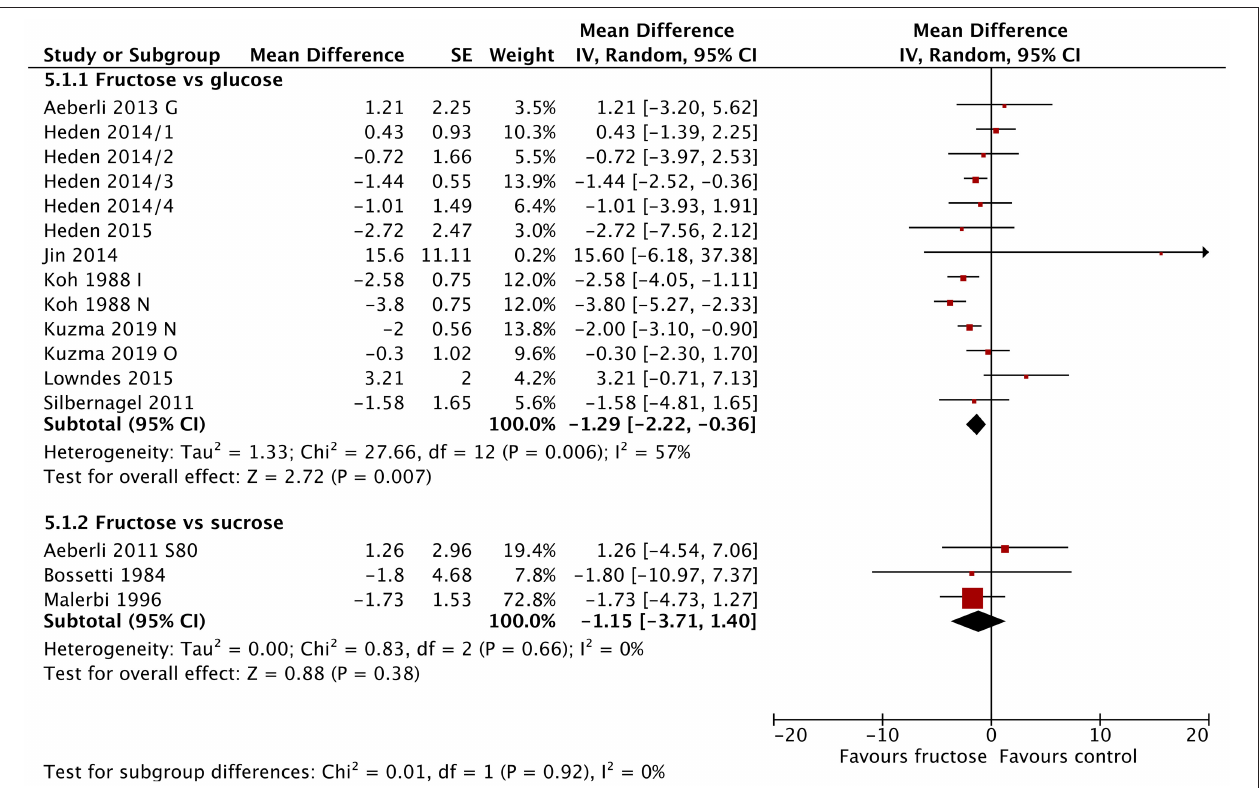
FIGURE 3 | Subgroup meta-analysis of fasting blood insulin following isoenergetic substitution of glucose or sucrose by fructose in food or beverages by substituted sugar. Values are mean differences (95% CIs) (expressed as µ IU/mL) between fasting blood glucose after fructose consumption and fasting blood glucose following glucose or sucrose consumption. IV, inverse variance; SE, standard error; G, glucose; S, sucrose; I, impaired glucose tolerance, N, normal glucose tolerance/body weight; O, overweight.